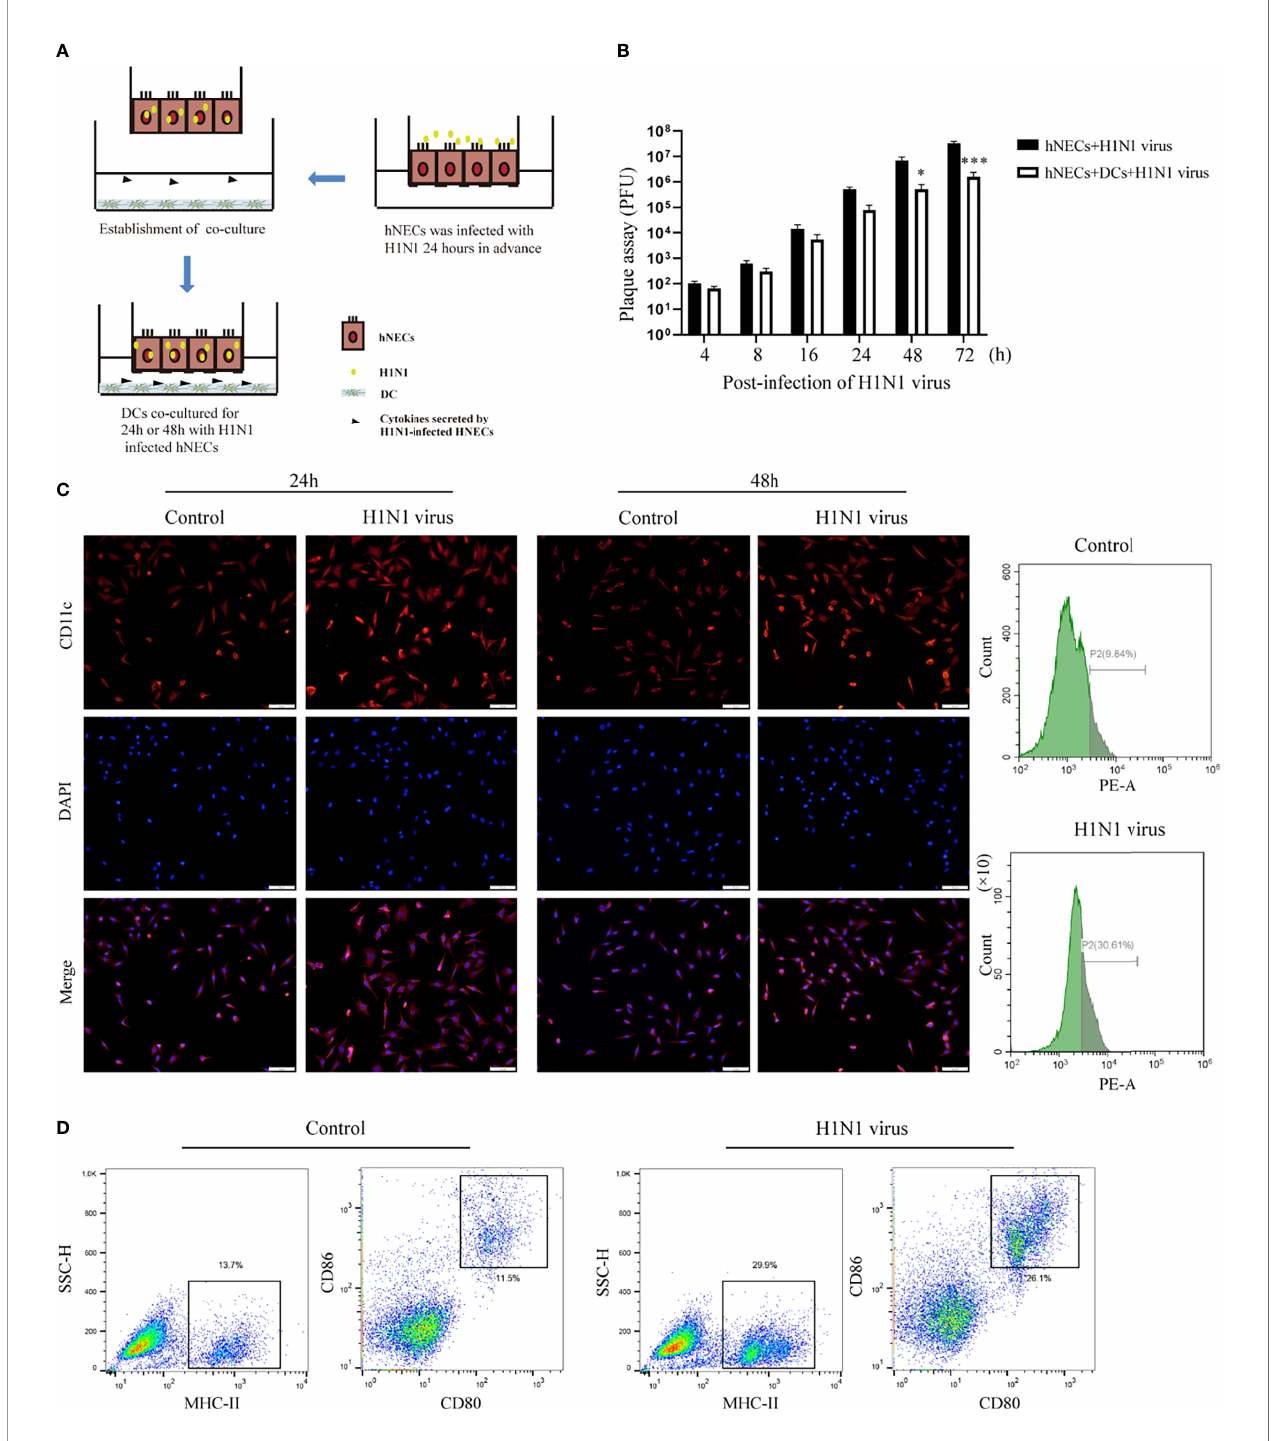
FIGURE 3 | Co-culture of hNEC cells after H1N1 virus infection with DCs induces DCs maturation and recruitment. (A) Schematic diagram of the co-culture of hNEC cells after H1N1 virus infection and DCs cells. (B) Plaque formation assay was used to detect the expansion of H1N1 virus in hNEC cells alone and hNEC cells co-cultured with DCs cells. (C) Immuno fl uorescence images showed the recruitment of DCs after H1N1 virus-infected and uninfected hNEC cells were co-cultured with DCs for 24h and 48h. The red fl uorescence represents CD11c-speci fi c staining, and the blue fl uorescence represents nuclear staining (DAPI), bar=50um. The peak graph on the right is the detection of CD11c red fl uorescence intensity after 24h co-culture of H1N1 virus-infected and uninfected hNEC cells and DCs cells by fl ow cytometry. (D) Flow cytometry was used to detect the proportion of CD80+CD86+ and MHCII+ cells after co-culture of H1N1 virus-infected and uninfected hNEC cells with DCs cells for 24 hours. Statistical signi fi cance is shown using the Student ’ s t test analysis, *P < 0.05; ***P <